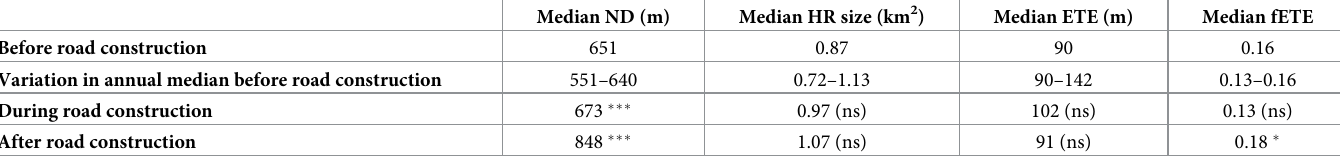
Table 3. Summary of median Nightly Distance (ND), Home Range (HR) size, Extra-Territorial Excursion (ETE) distance and frequency (fETE) during each phase of road